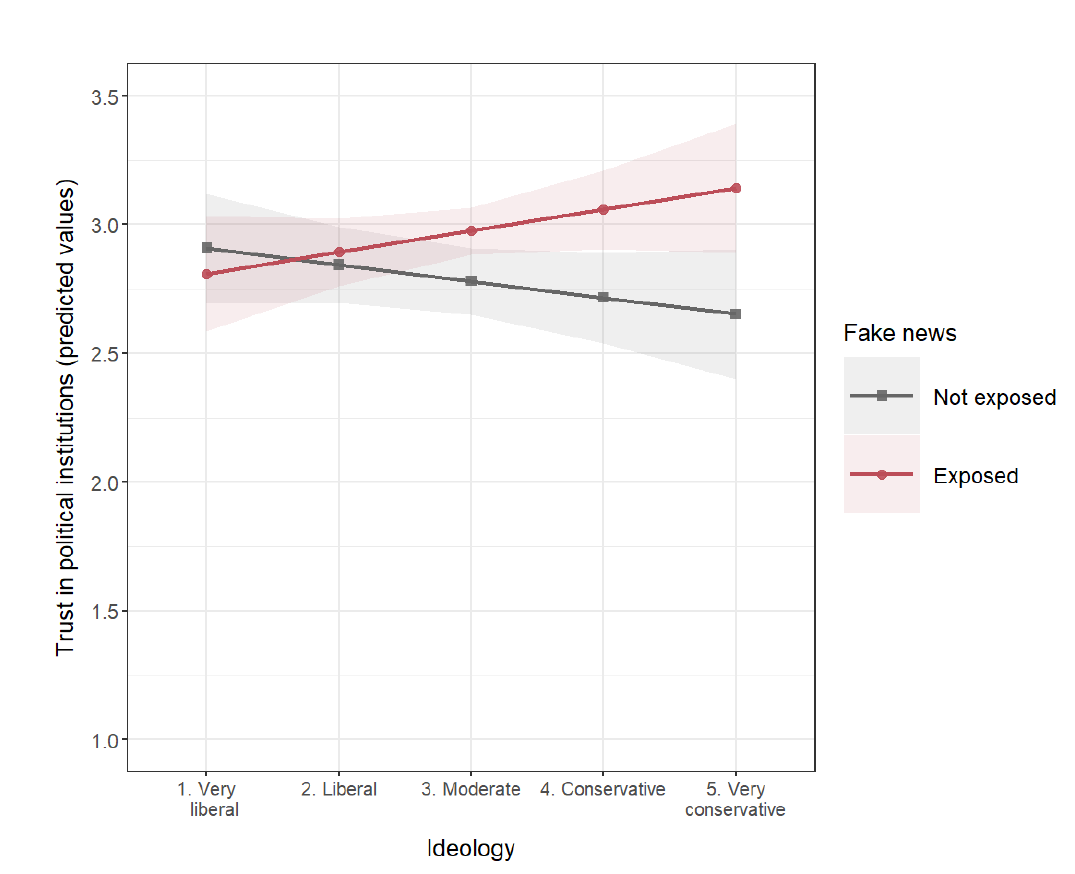
Figure 2. Interaction plot showing predicted values of trust in political institutions at different levels of ideology and fake news exposure, control variables held at